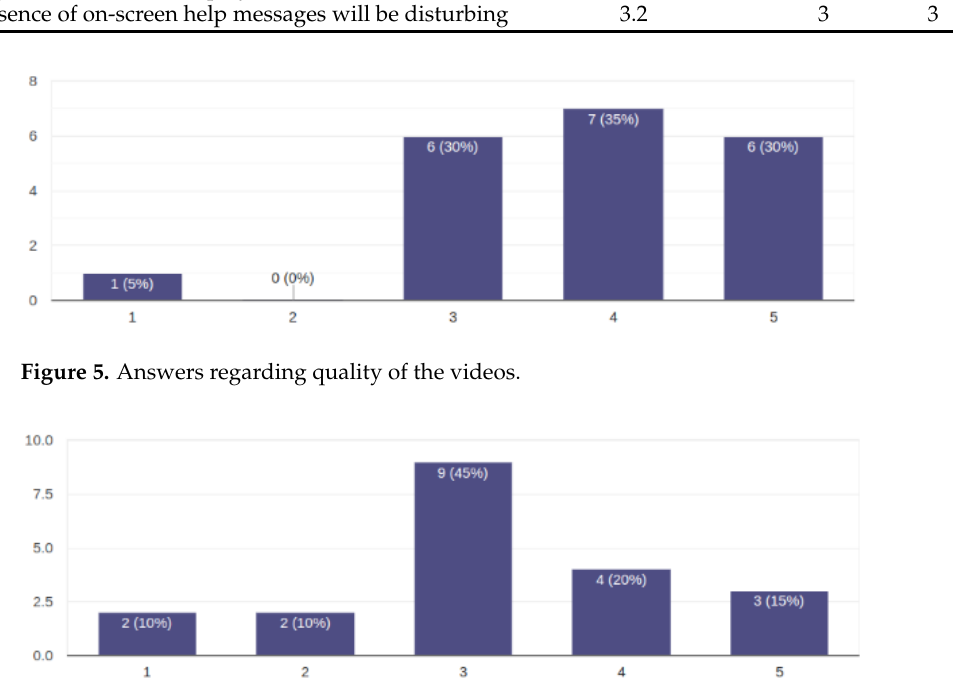
Figure 6. Answers regarding on-screen additional messages and